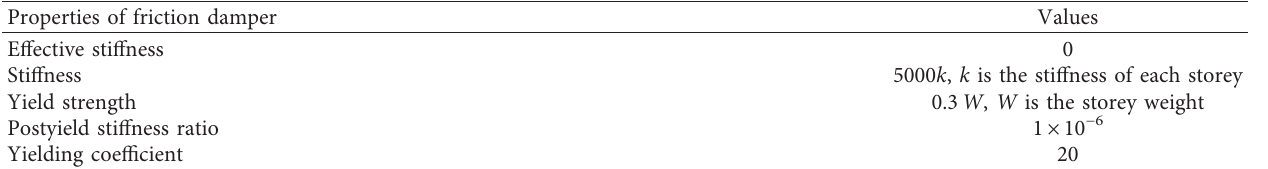
Figure 3: (a) Elastic behavior of brace, (b) hysteretic loop of friction damper, and (c) resultant elastoplastic behavior of the friction damper in brace. Table 1: Modeling properties of the elastic-plastic friction damper